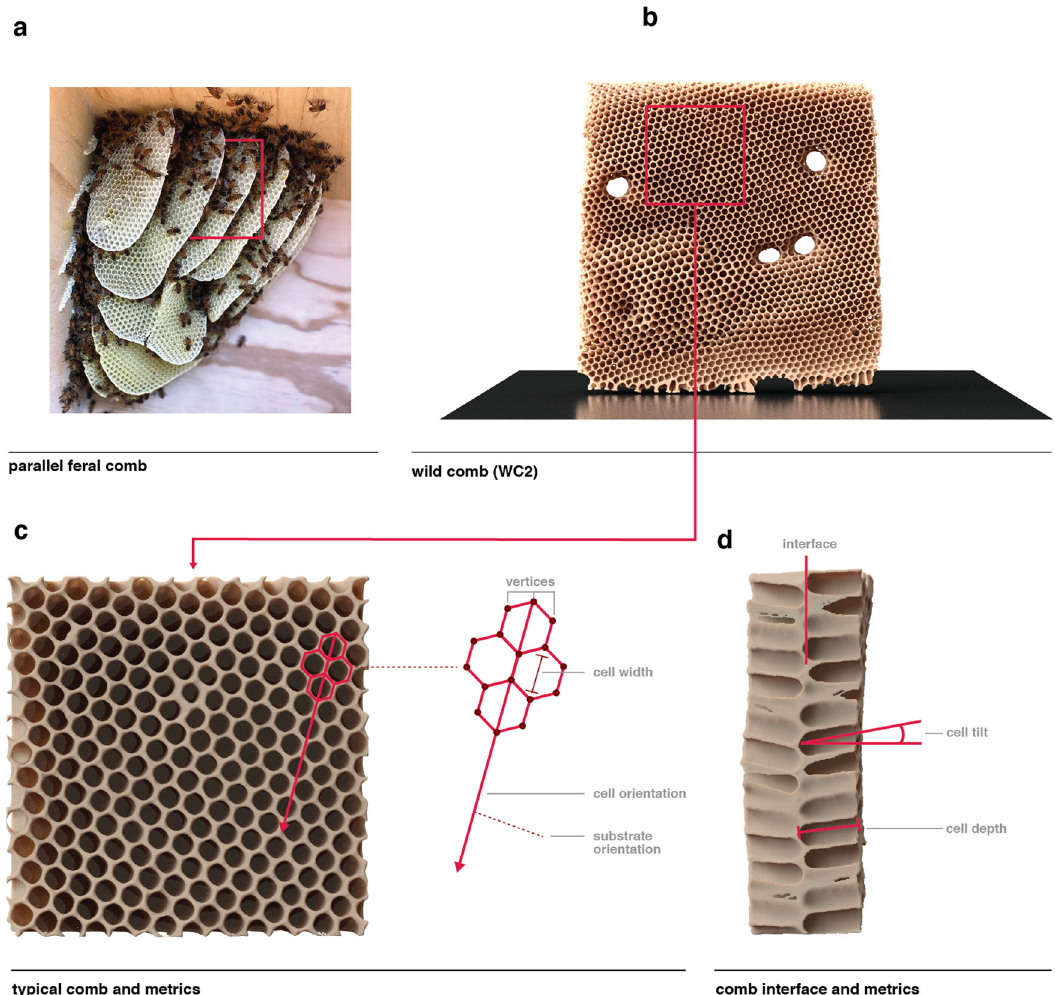
Fig. 1 General characteristics of A. mellifera comb. a A photograph of comb being constructed by a feral bee colony in Southern California demonstrates the typical parallel lobes of comb observed in A. mellifera hives (image courtesy of Super Bee Rescue, Santa Barbara, California). b A digital reconstruction of a section of feral comb, and ( c ), an isolated section of comb cells from the digital reconstruction in ( b ), outlining the characteristics of cells including vertex locations, the measurement of cell width, and cell orientation (which has been reported to be perpendicular to substrate orientation). d A 90-degree rotation of ( c ) outlines the interface where the basal side of cells meet, the angle of cell tilt is measured in reference to the normal of the comb ’ s dominant plane, and cell depth is measured along this